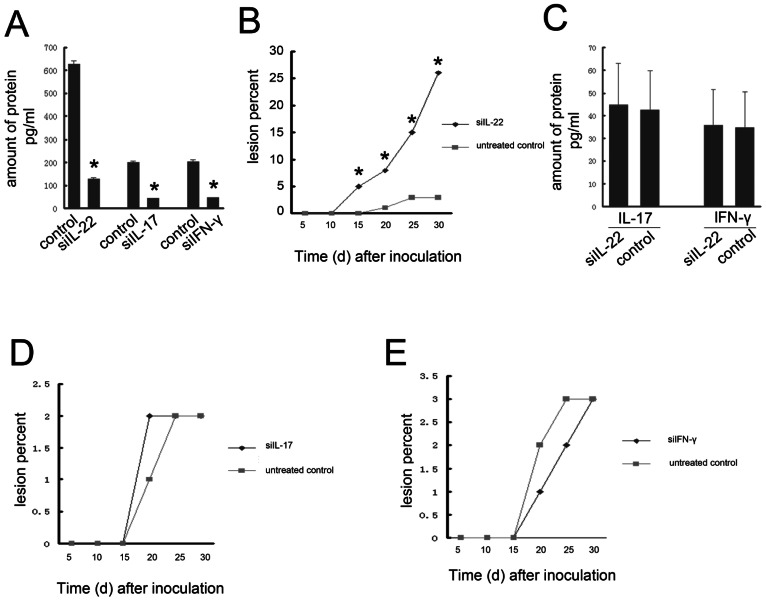
siRNA-mediated silencing of IL-22 sensitizes mice to R. pusillus-induced skin damage.(A) The expression of IL-22, IL-17, and IFN-γ was analysed by ELISA after transient transfection of targeting siRNAs, *P<0.05.(B) Mice were injected intradermally every other day for 16 days with 20 µL PBS, Rate of corresponding skin damage measured on days between siRNA injections targeting IL-22(n = 100/per group, *P<0.05. (C) Effect of siRNA-silenced IL-22 on IL-17 and IFN-γ was evaluated by ELISA, data are presented as averages (n = 10/per group) relative to expression in mice transfected with non-targeting siRNA (control). (D)Rate of corresponding skin damage measured on days between siRNA injections targeting IL-17 (n = 100/per group). (E) Rate of corresponding skin damage measured on days between siRNA injections targeting IFN-γ(n = 100/per group).